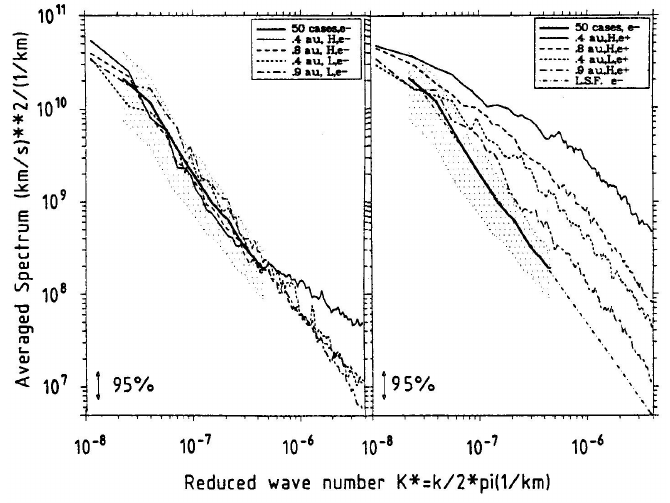
Figure 43: Power density spectra 𝑒 − and 𝑒 + computed from 𝛿𝑧 − and 𝛿𝑧 + fluctuations. Spectra have been computed within fast (H) and slow (L) streams around 0.4 and 0.9 AU as indicated by different line styles. The thick line represents the average power spectrum obtained from all the about 50 e – spectra, regardless of distances and wind speed. The shaded area is the 1 𝜎 width related to the average. Image reproduced by permission from Tu and Marsch (1990b), copyright by